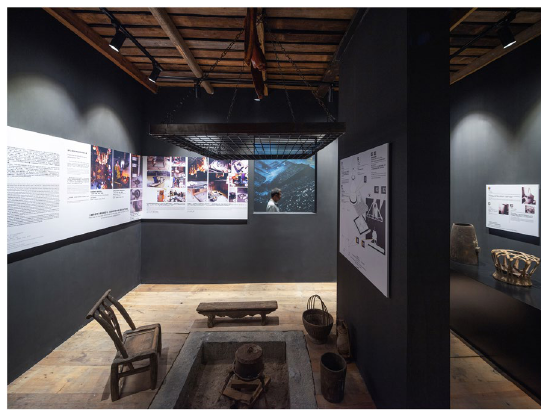
Fig. 2 The firepit custom theme in the exhibition (Source: Yilong